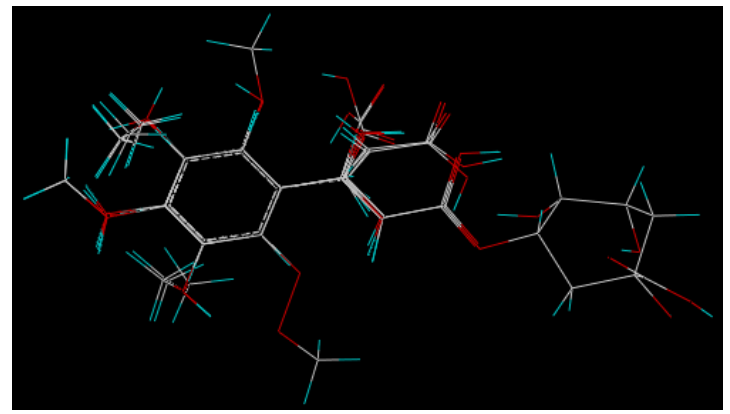
Figure 3. Alignment of the compounds used in the training